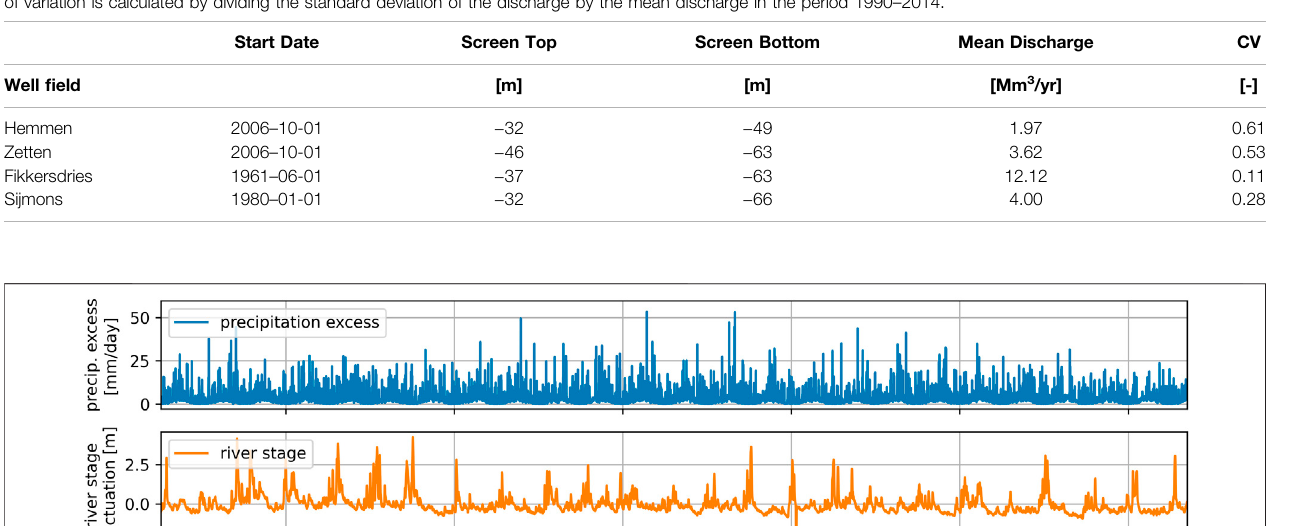
(7.1 km). Precipitation-excess, reference evaporation, river stage, and pumping rates from all three pumping wells are shown in Figure 4 . Pumping at the well fi eld in Fikkersdries started in the 1960s, before the start of the head observations. The pumping relatively constant pumping rate until 2015, after which the